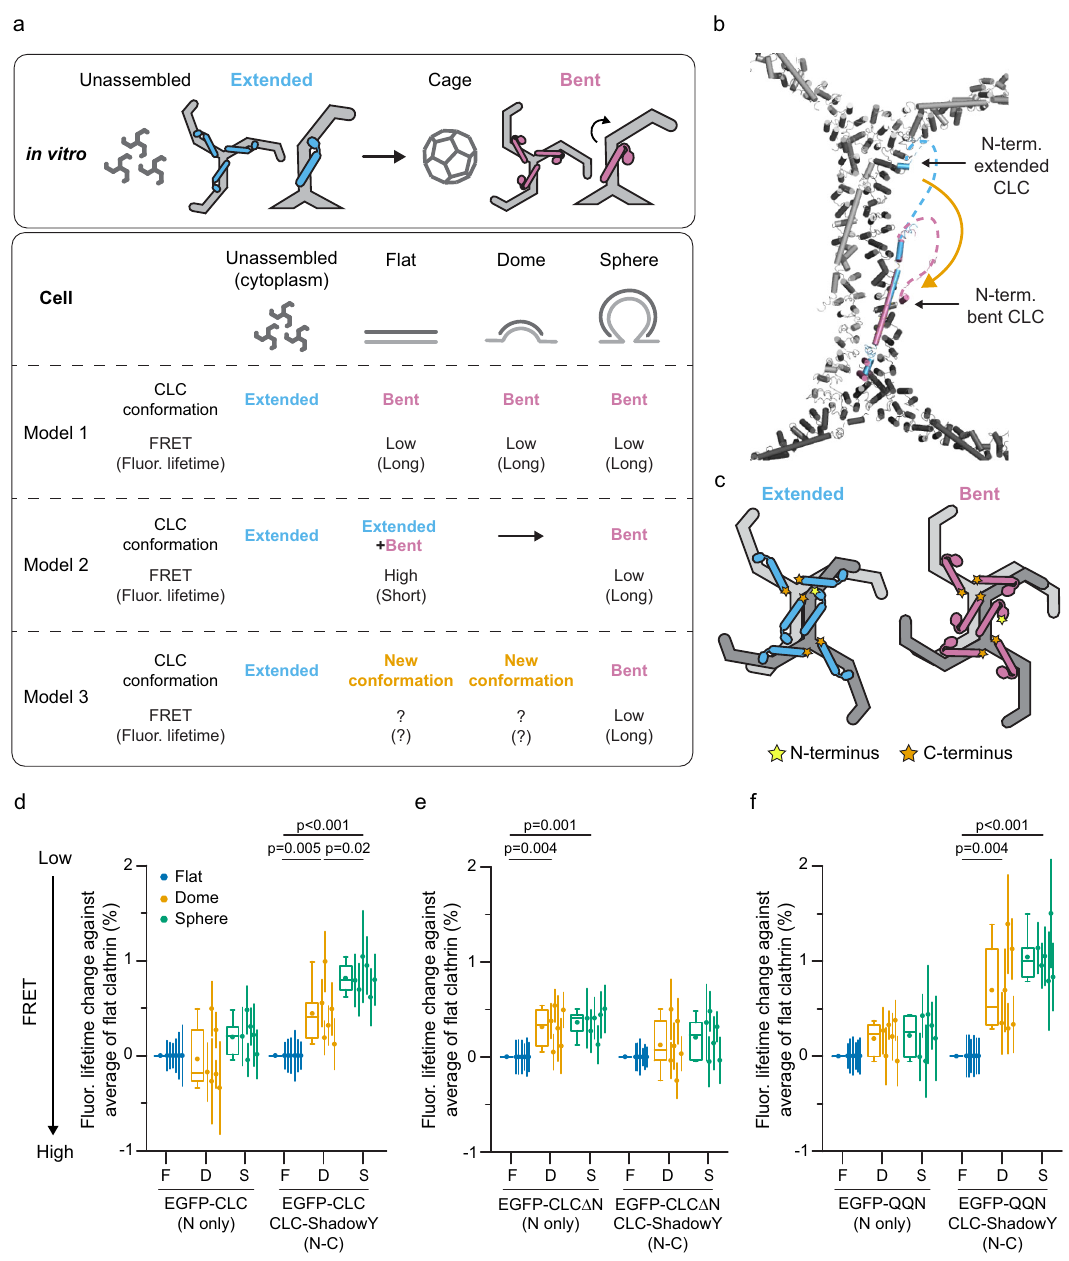
Fig. 2 | CLC conformational changes in cells. a Schematic models of CLC con- formation at different assembly states in vitro or in living cells and their expected FRETef fi cienciesbetweentheN-andC-terminusofCLCs. b Astructuralmodelwith the assumption that either extended (light blue) or bent conformations (magenta) ofCLCsassembleintothelattice.ThemodelisbasedonPDB3LVGand6WCJ.3LVG isoverlaidwith6WCJ. c Schematicmodelsoftwoassembledtriskeliawithextended (left) or bent CLCs (right). A CLC N-terminus position (yellow) and C-terminus positions of surrounding CLCs (orange) are shown. d FRET-CLEM was performed on HeLa cells expressing either EGFP-CLC, or EGFP-CLC and CLC-ShadowY. Mean fl uorescence lifetimes from single CCSs were analyzed by categorizing them accordingtolatticestructures( fl at,domedandsphere)andtheywerecomparedto